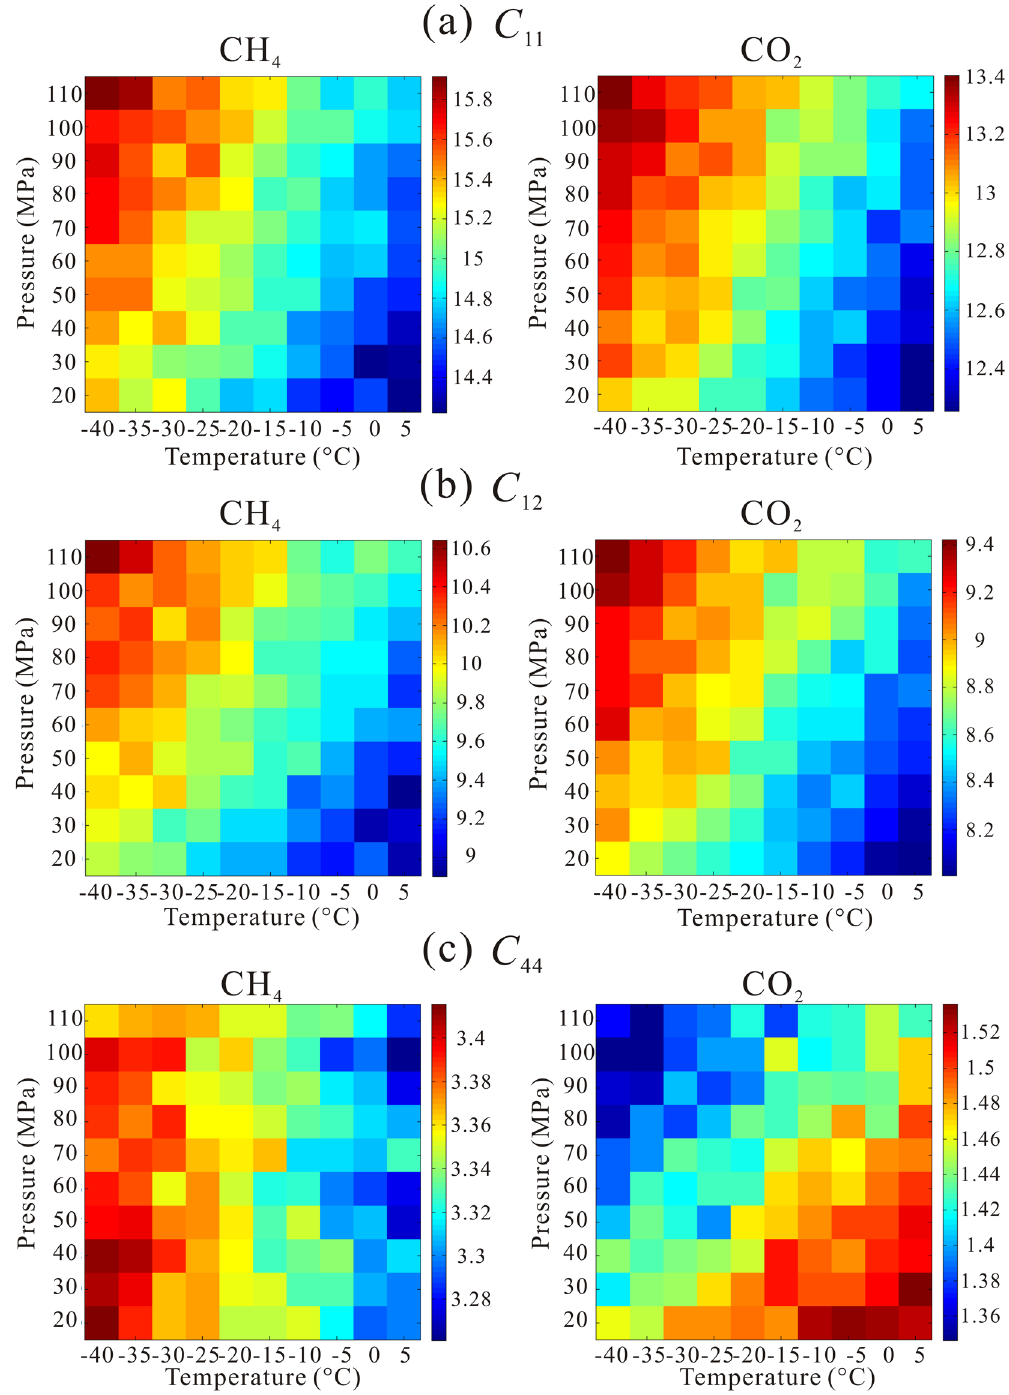
Figure 2. Three independently evaluated elastic constants of CH 4 and CO 2 hydrate with full occupancy from − 40 °C to 5 °C and 20 MPa to 110 MPa. Red represents large value of elastic constant while blue represents small value with unit of